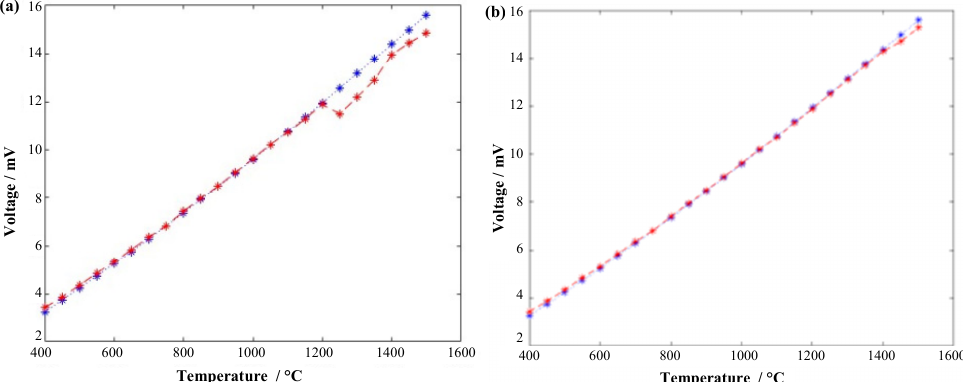
Figure 11. Comparison of the thermopotential versus temperature curves of thin-film thermocouples and standard thermocouples: ( a ) Fit of test data of thermocouples connected by keying; ( b ) Fit of thermocouple test data connected by soldering method.